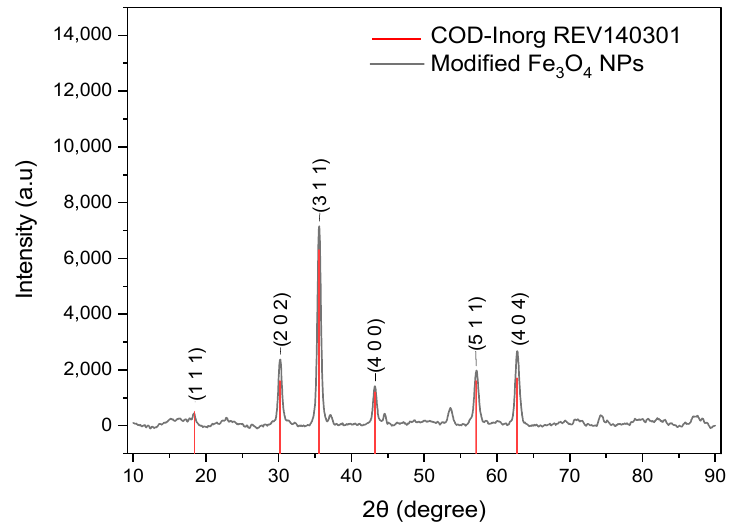
Figure 10. XRD patterns of modified Fe 3 O 4 NPs.